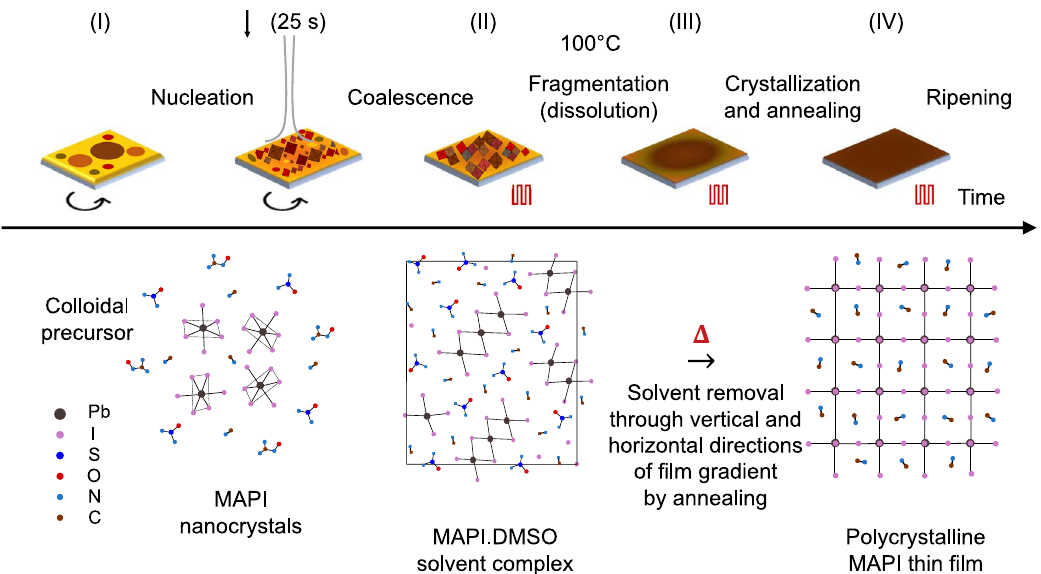
Fig. 4 Four phases of fi lm formation during spin coating. Phase I: The thin fi lm consists of colloidal precursors of photoinactive solid precursors (PbI 2 and CH 3 NH 3 I) and liquid solvents (CH 3 ) 2 N-HCO and (CH 3 ) 2 SO. Nucleation of MAPI nanocrystals and conversion to phase II where the nanoparticles trimerize into thermodynamically stable orthorhombic solvent-complex of Pb 3 I 8 .2(CH 3 ) 2 SO.2CH 3 NH 3 with remainders of stable perovskite phase formed during nucleation. Phase III: Thermal decomposition of solvent-complex leading to the removal of plumboiodide coordinated solvent molecules at 100 °C from the thin fi lm and the eventual dissolution-recrystallization of CH 3 NH 3 PbI 3 from the fi lm thickness. Phase IV: Perovskite crystallization complete and thermal ripening process of the thin fi